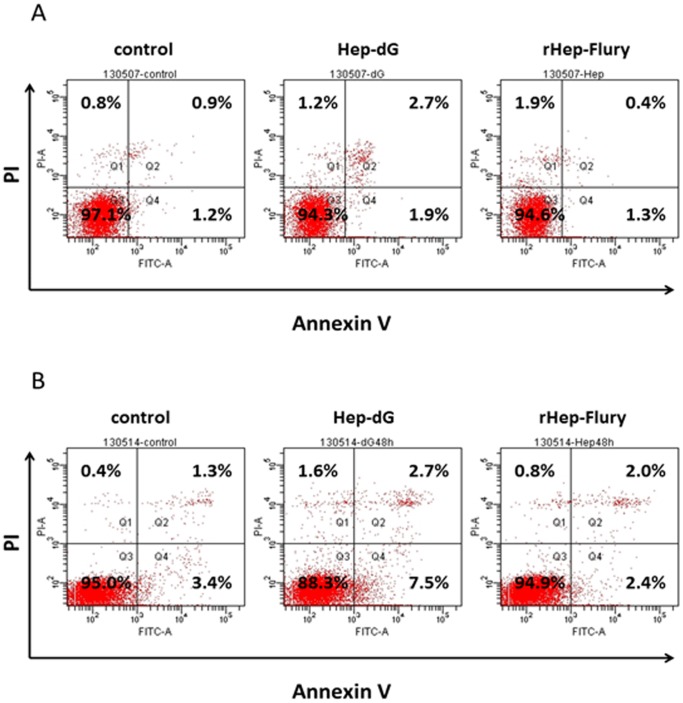
Apoptosis induced by virus HEP-dG and rHEP-Flury.The BHK cells and SK cells were infected with virus HEP-dG and rHEP-Flury. The apoptosis was analysed by Flow cytometry. The lower right part (Annexin V+/PI−) was considered as early stage of apoptotic cells and top right part (Annexin V+/PI+) was considered as late stage of apoptotic cells. The lower left part(Annexin V−/PI−) was considered as viable cells and the upper left part (Annexin V−/PI+) was considered as necrotic cells. BHK cells infected with virus HEP-dG and rHEP-Flury(A). SK cells infected with virus HEP-dG and rHEP-Flury(B). On the BHK and SK cells, HEP-dG induced more apoptosis than rHEP-Flury (p<0.01).